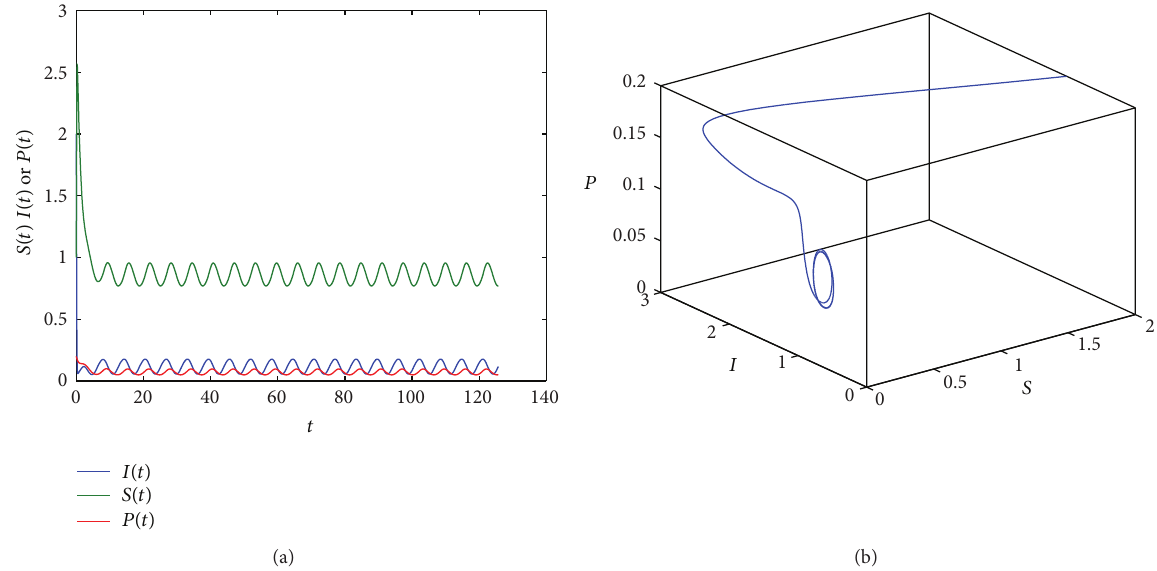
Figure 2: (a) The movement paths of 𝑆 , 𝐼 , and 𝑃 as functions of time 𝑡 . The graph of the trajectory in (𝑆,𝐼, 𝑃) -Space is shown in (b). 𝑅 ∗ = 1.2288 > 1 . The disease is